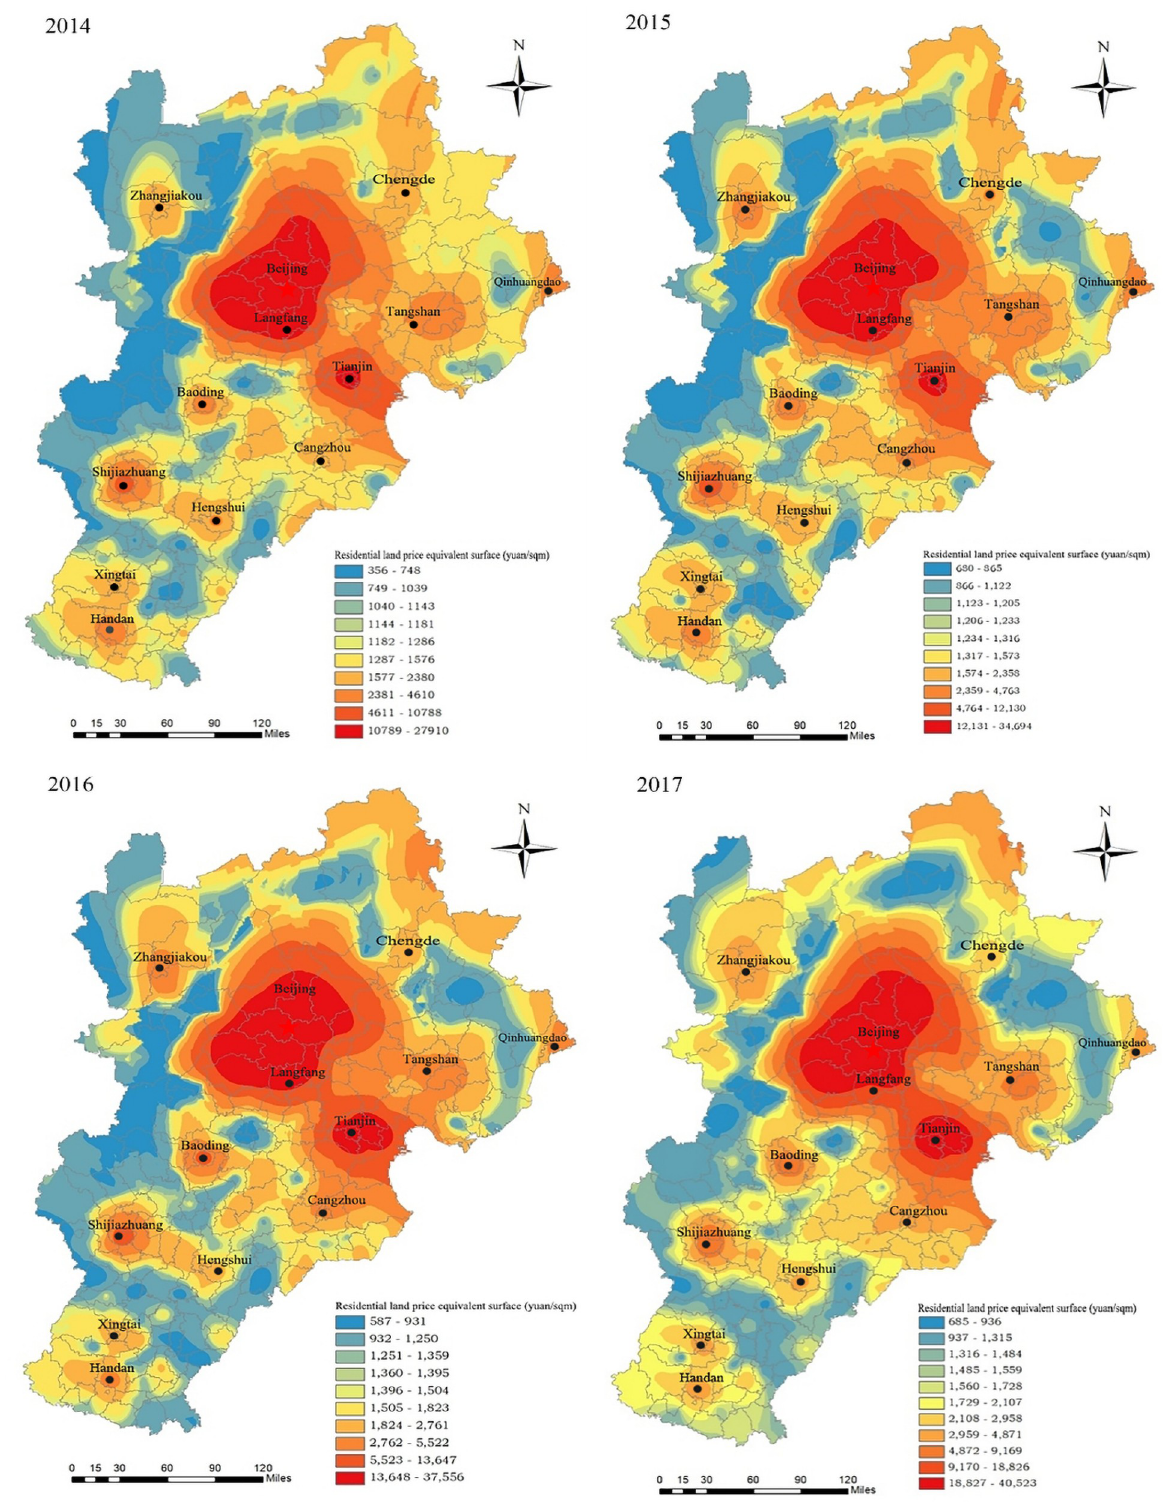
Fig 3. Equivalent map of residential land prices in the Beijing-Tianjin-Hebei region from 2014 to 2017.